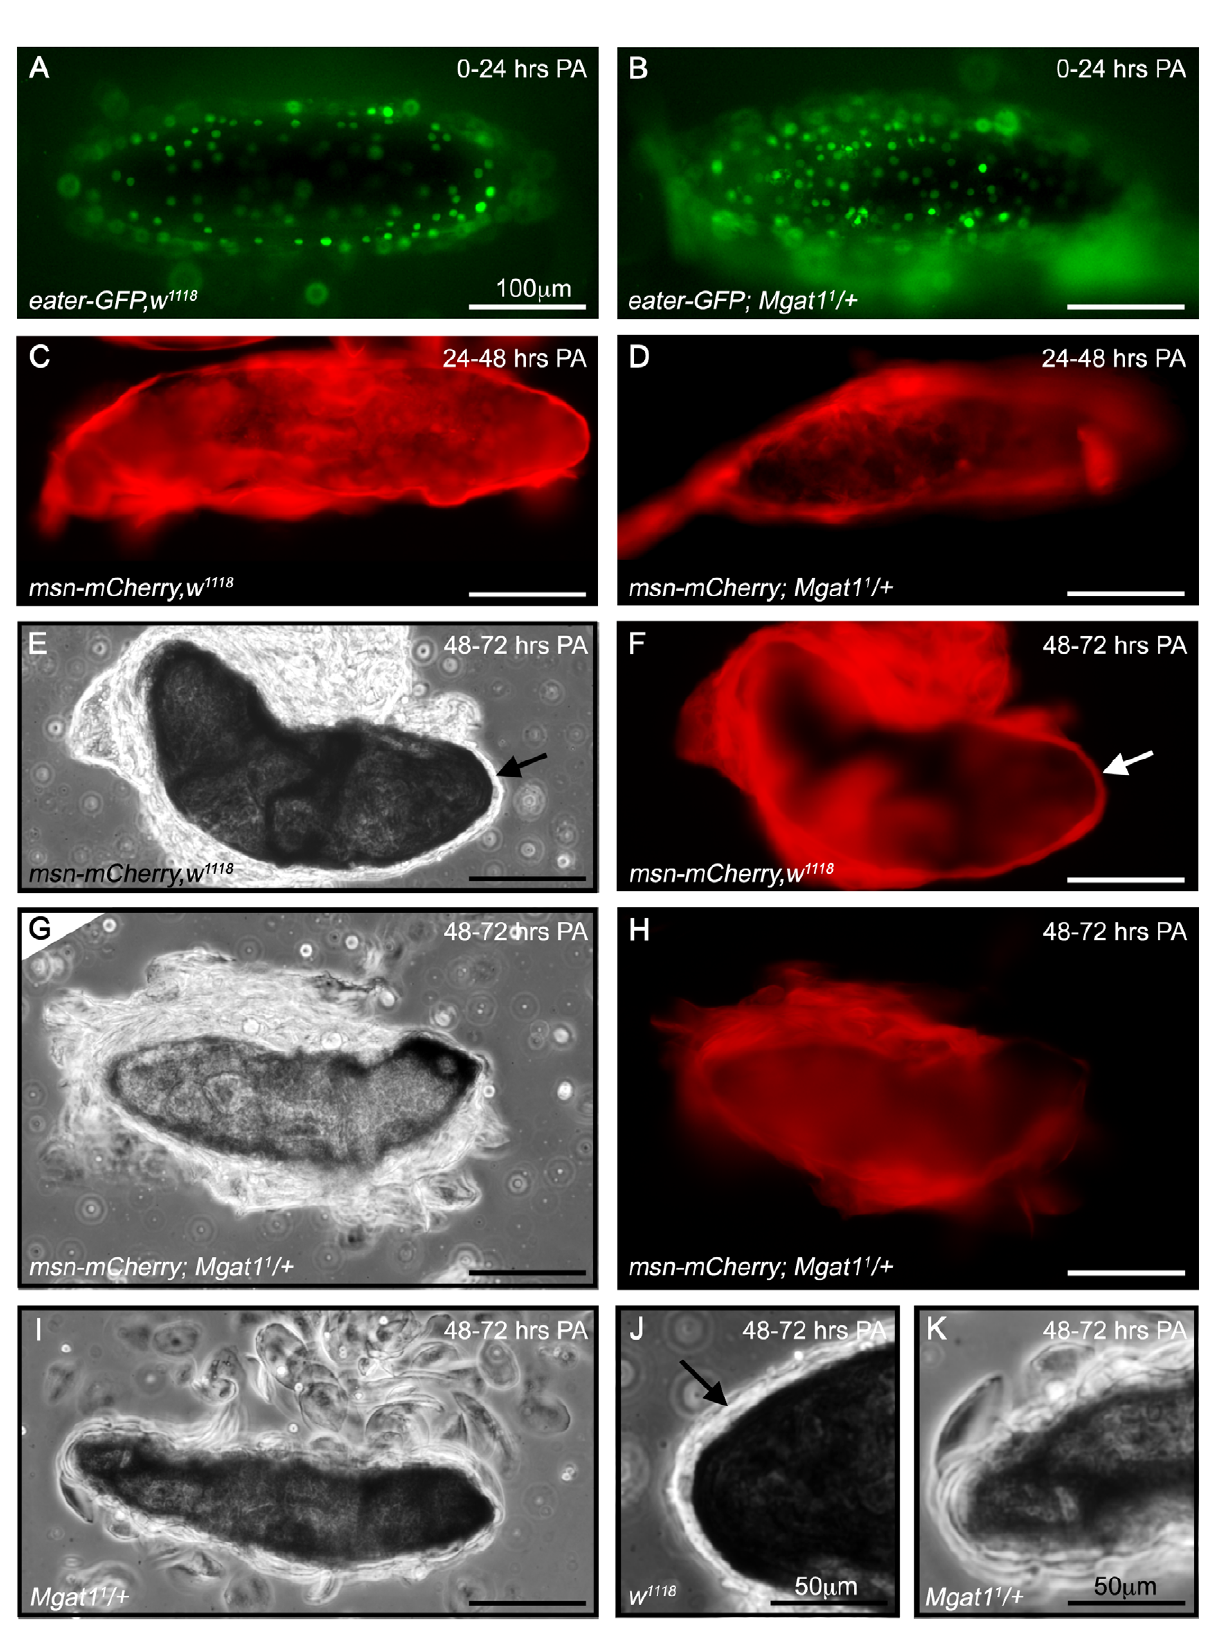
Figure 6. Mgat1 mutants successfully initiate capsule formation but have a failure in lamellocyte consolidation. Brightfield and fluorescent images of L. clavipes eggs dissected from attacked fly larvae. (A,B) Plasmatocytes are marked by the expression of eater-GFP in w 1118 (A) and Mgat1 1 / + (B) backgrounds. At 0–24 hours PA, plasmatocytes in both genetic backgrounds migrated to, and surrounded, the wasp egg. (C–H)